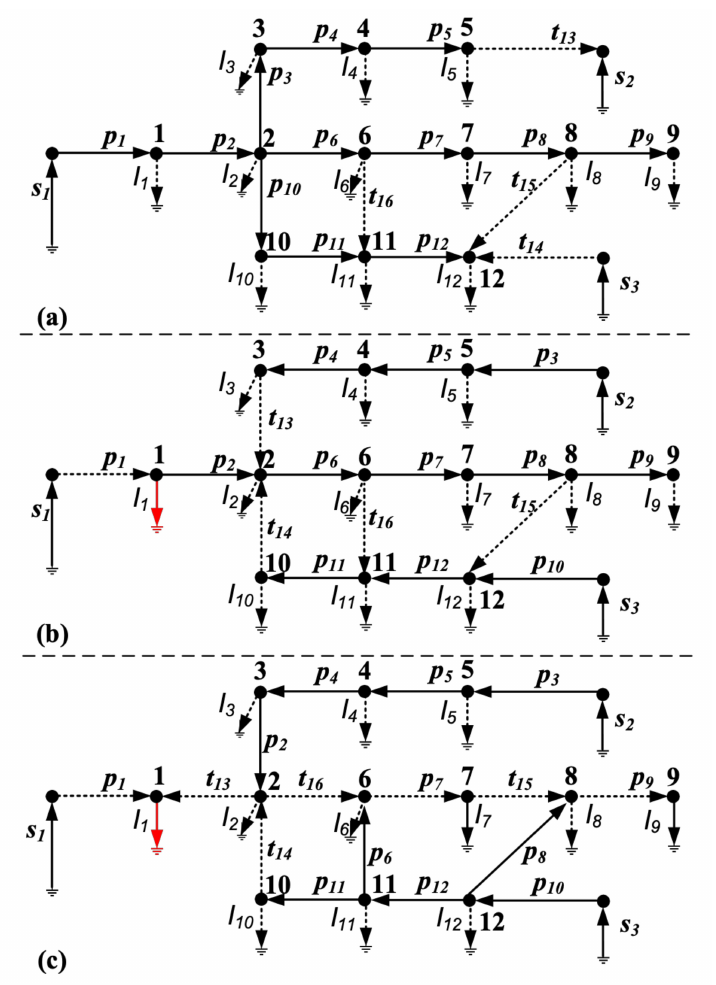
Figure 2. ( a ) An illustrative example, the configuration distribution network (DN) after ( b ) first and ( c ) last restoration